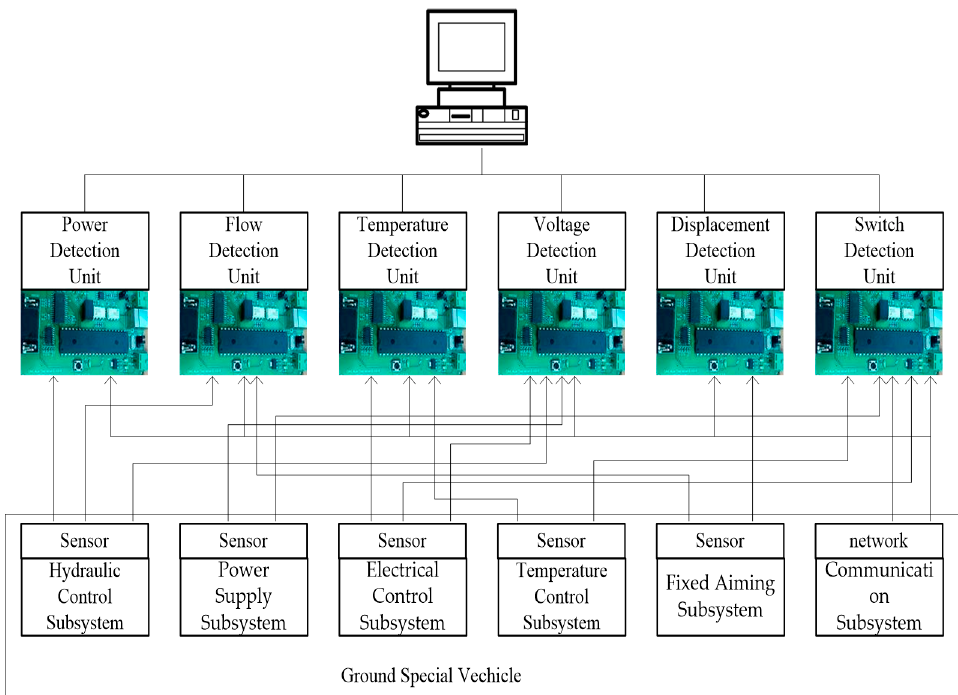
Figure 1. Topology of the data acquisition